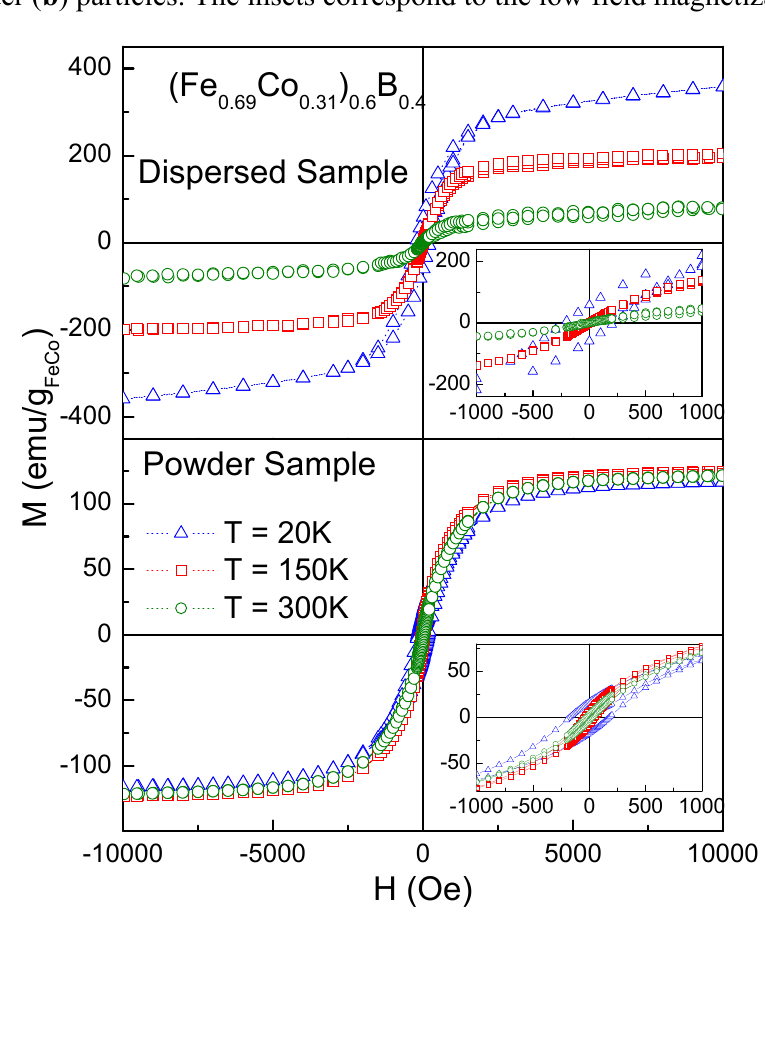
Co )B dispersed 0.69 0.31 0.4